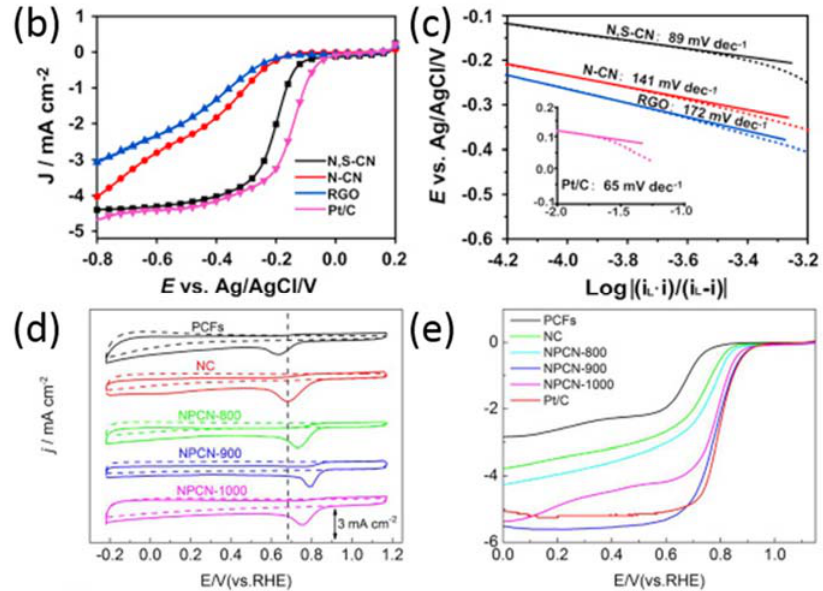
Figure 4. ( a ) Schematic illustration of the preparation of N,S-CN. ORR LSVs ( b ) and Tafel slope ( c ) of N,S-CN, N-CN, RGO, and Pt/C [82]. Copyright 2016 Elsevier. CV curves in N 2 and O 2 -saturated 0.1